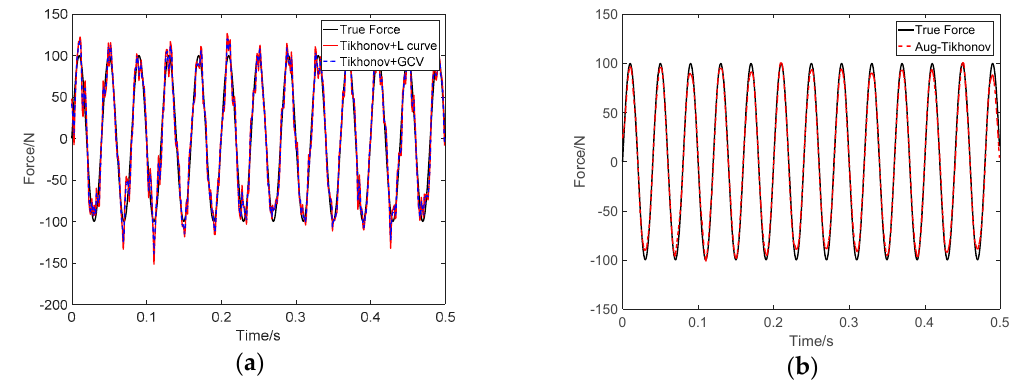
Figure 6. Identification result of sinusoidal load at SNR 30 dB: ( a ) Tikhonov method; ( b ) the proposed method.